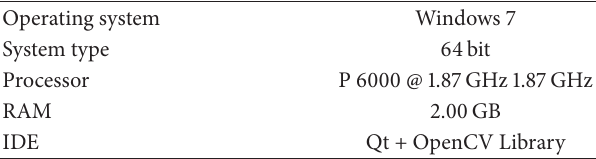
Table 11: The notebook’s characteristics for the actual